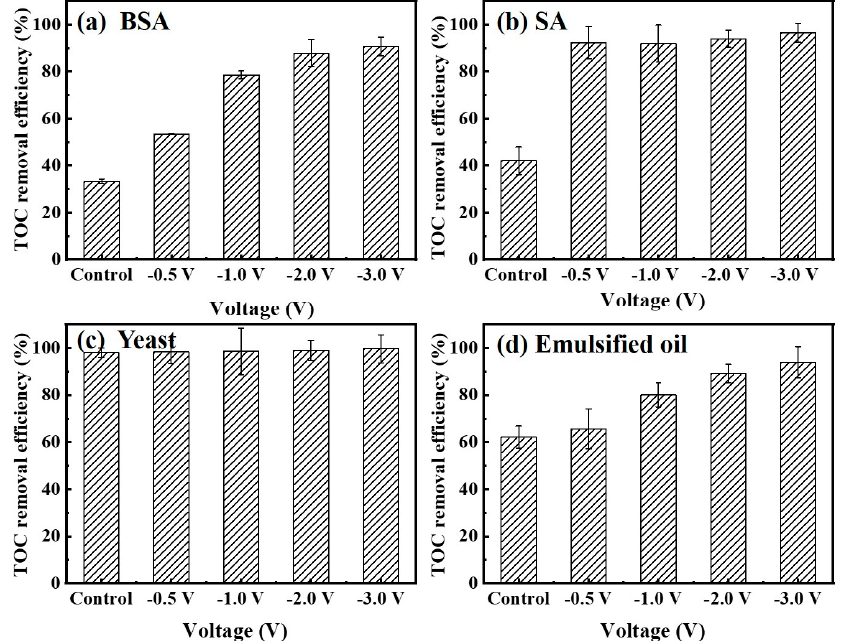
Figure 7. Total organic carbon (TOC) removal efficiency by a Car-PES membrane demonstrating anti- anti-fouling capacity with various foulant solutions under di ff erent negative voltages: ( a ) BSA, ( b ) SA, fouling capacity with various foulant solutions under different negative voltages: ( a ) BSA, ( b ) SA, ( c ) ( c ) yeast and ( d ) emulsified oil (conditions: (BSA) in = 10 mg / L, (SA) in = 10 mg / L, (yeast) in = 10 mg / L yeast and ( d ) emulsified oil (conditions: (BSA) in = 10 mg/L, (SA) in = 10 mg/L, (yeast) in = 10 mg/L and and (emulsified oil) in = 10 mg / (emulsified oil) in = 10 mg/L).